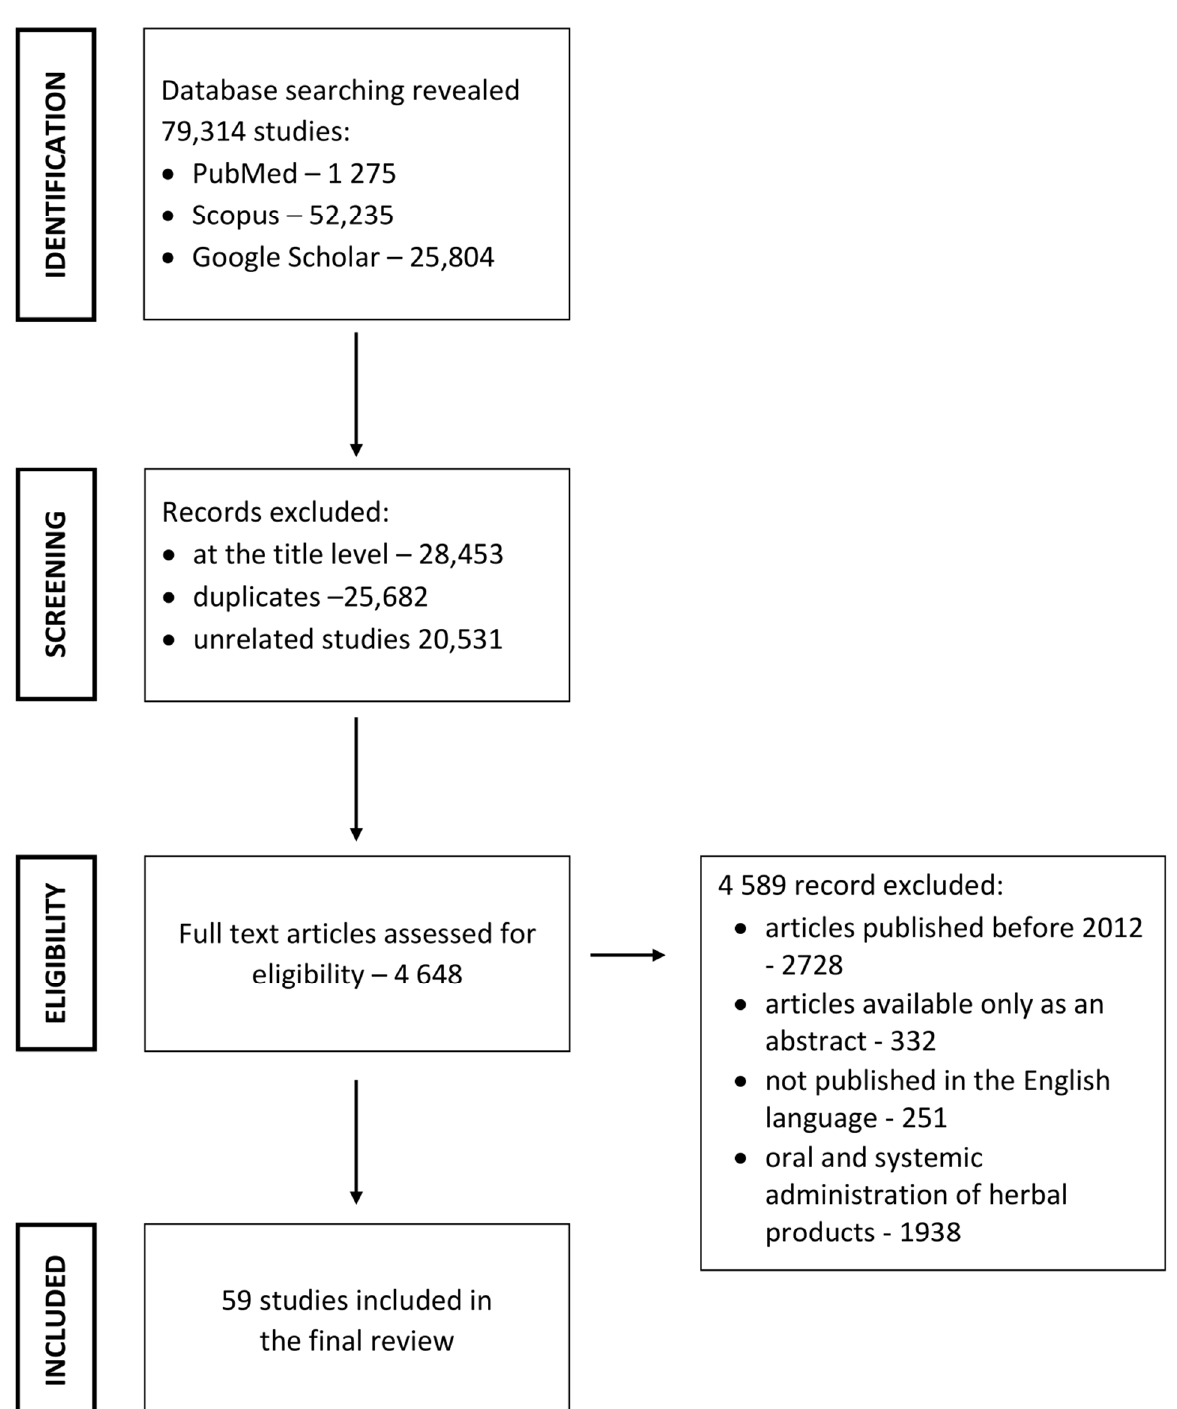
Figure 1. Search strategy used to identify relevant articles.